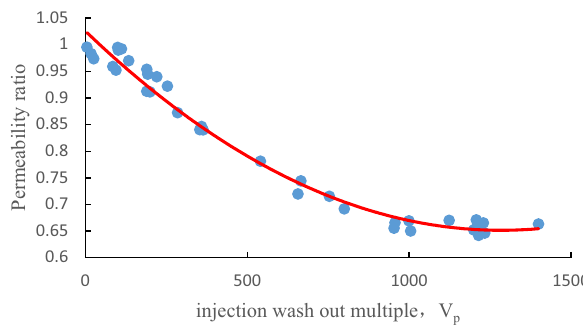
Fig. 1 Permeability variation with the injection wash out multiple in a middle porosity and middle permeability reservoir